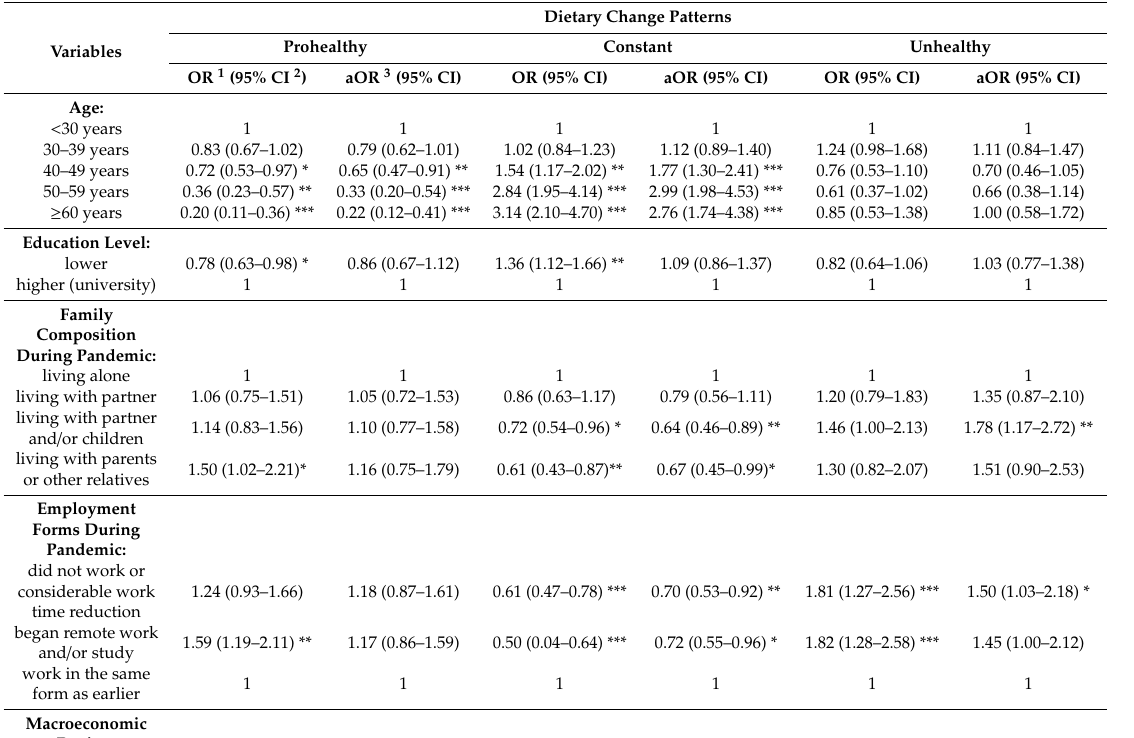
Table 3. Associations between dietary changes patterns and sociodemographics, BMI before pandemic, or lifestyle behavior changes during COVID-19